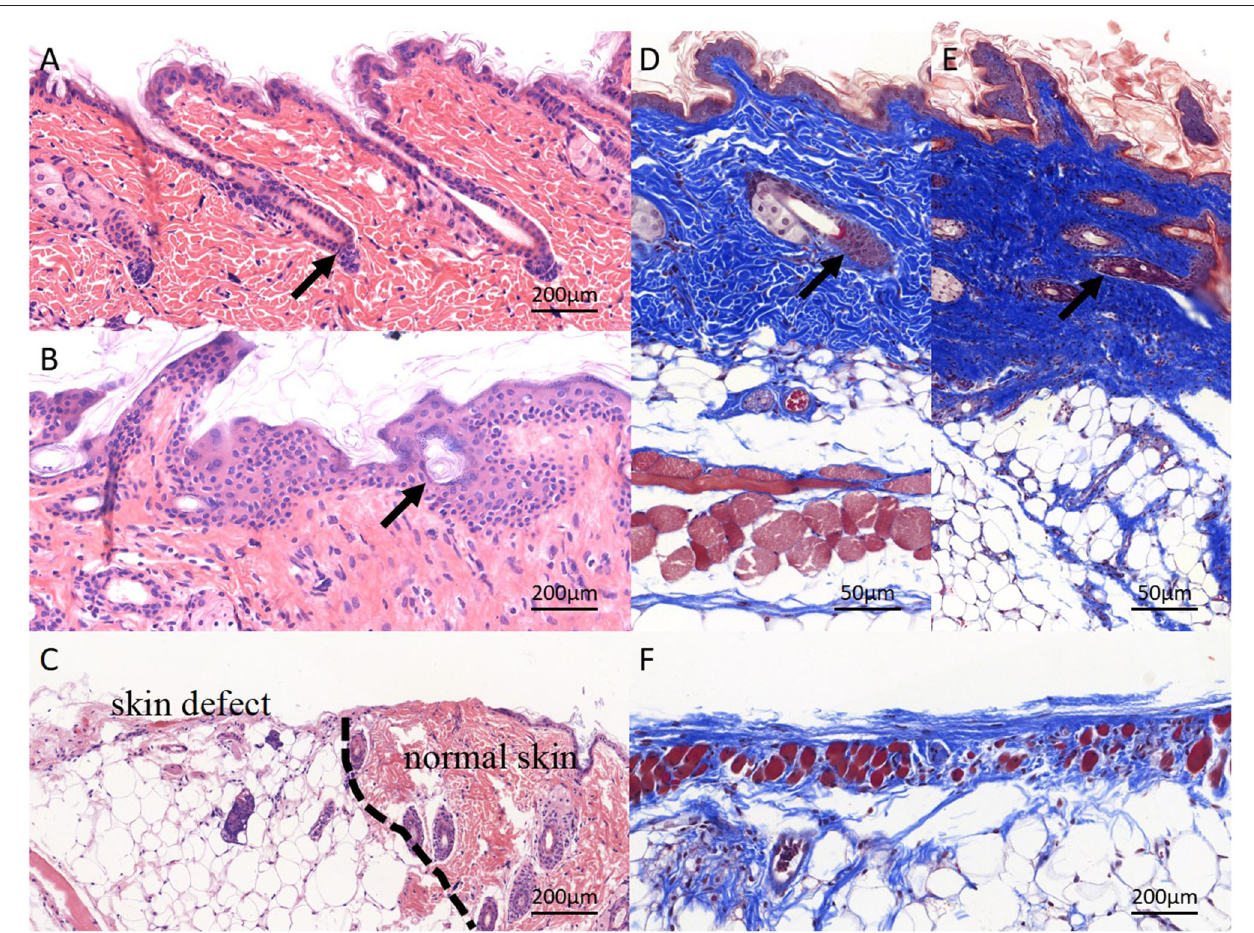
FIGURE 9 | Pathological staining of repaired skin defects in Balb/c mouse. (A,D) HE and masson staining of normal skin, and the skin structure is complete, and the layers are clear; (B,E) electrospun nanofiber membranes repaired skin. The structure of skin tissue is disorder, several hair-follicle-like structures can be seen (black arrow), layers are clear basically, the newly deposited collagen structure is dense, and the dermal structure is completely covered; the (C,F) control group. No obvious skin structure was observed, collagen production was weak, and skin defect was not covered by